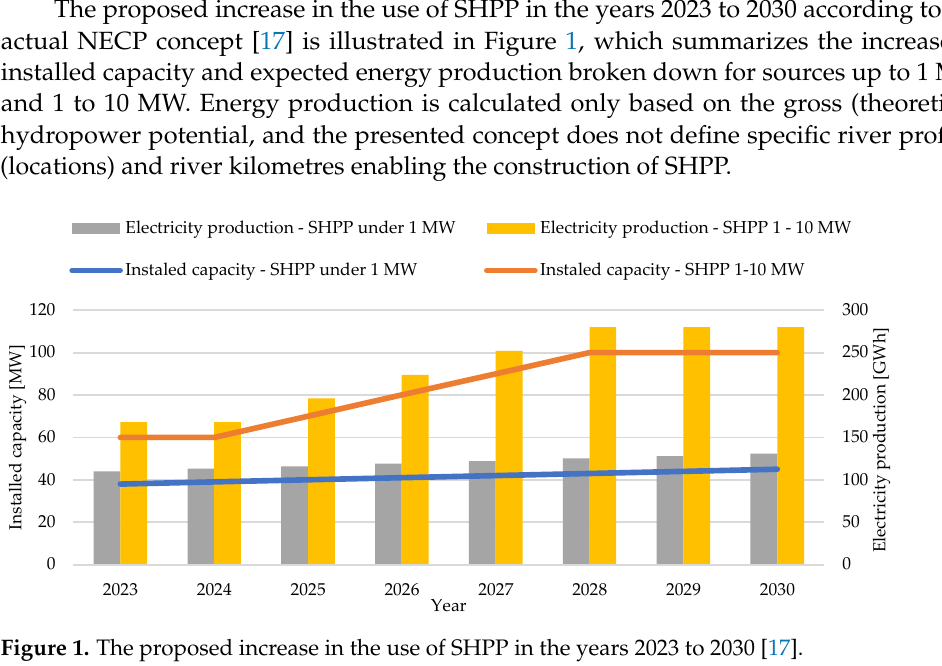
Figure 1. The proposed increase in the use of SHPP in the years 2023 to 2030 [17].